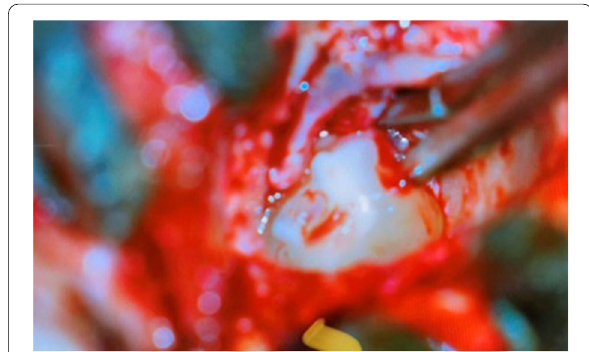
Fig. 2 Placing PRF membrane lateral to temporalis fascia graft